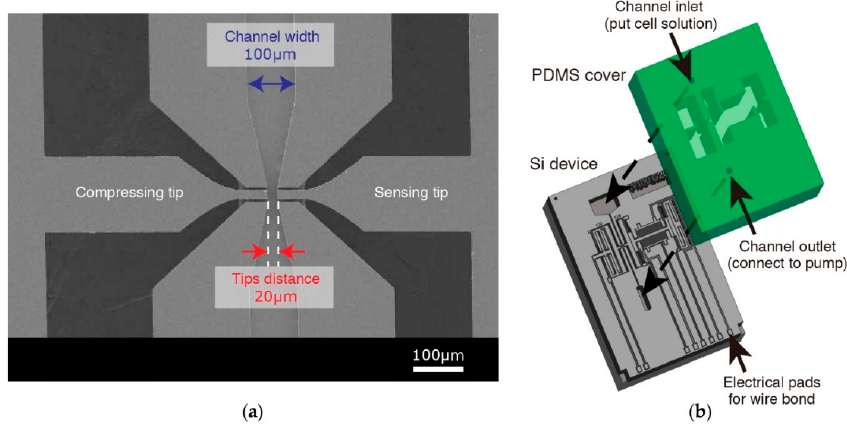
Figure 2. ( a ) Scanning electron microscope (SEM) image of the handling area where compressing and sensing tips access the microfluidic channel, ( b ) Schematic view of polydimethylsiloxane (PDMS) cover alignment.